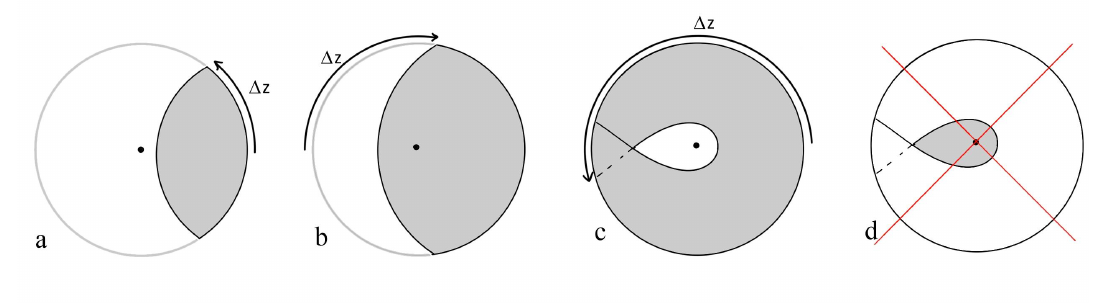
Figure 4. Types of bulk regions associated with CFTs on a strip. (a) The region does not include the Euclidean horizon. (b) The region includes the Euclidean horizon. (c) The region does not include the Euclidean horizon and is multiply wound. (d) Windings less than zero are not